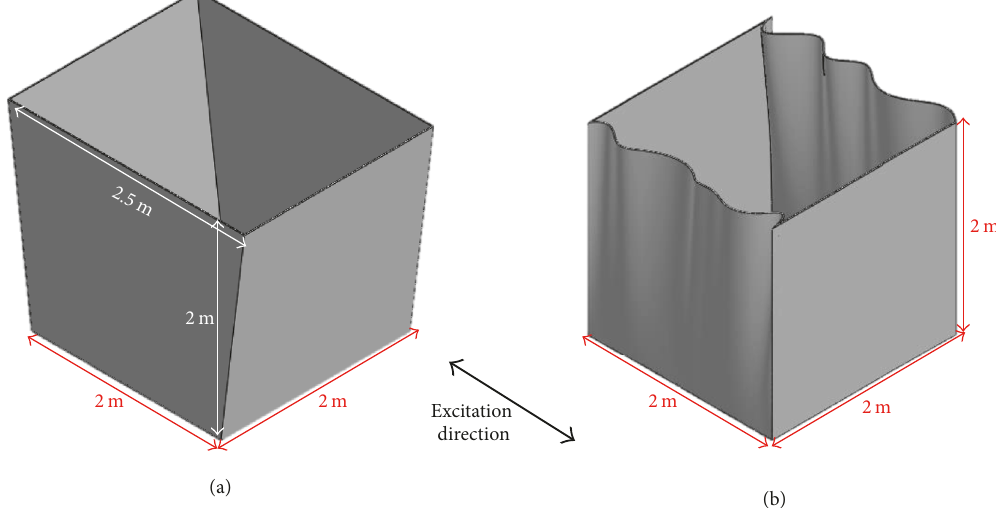
Figure 4: Size of the PVC fabric (a) before and (b) after being fitted into the laminar